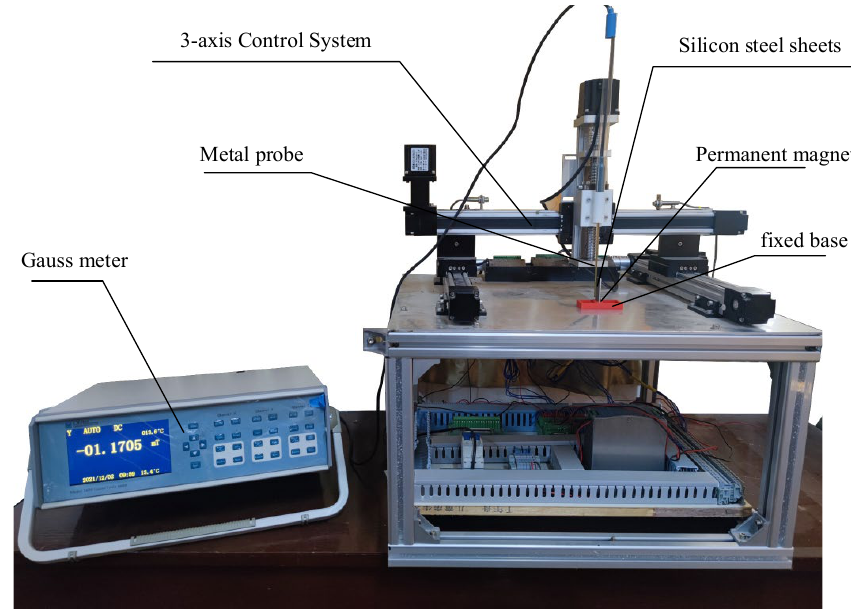
Figure 10. Experiments with maglev weft knitting needles. The decreasing trend of magnetic induction in Figure 11 can verify the correctness of the magnetic force trend in Figure 3. Furthermore, the experiment also shows that at smaller center distances of the needles, the magnetic induction strength between the permanent magnet needles is larger, which generates stronger magnetic field disturbances and thus interferes with the stability of the needle